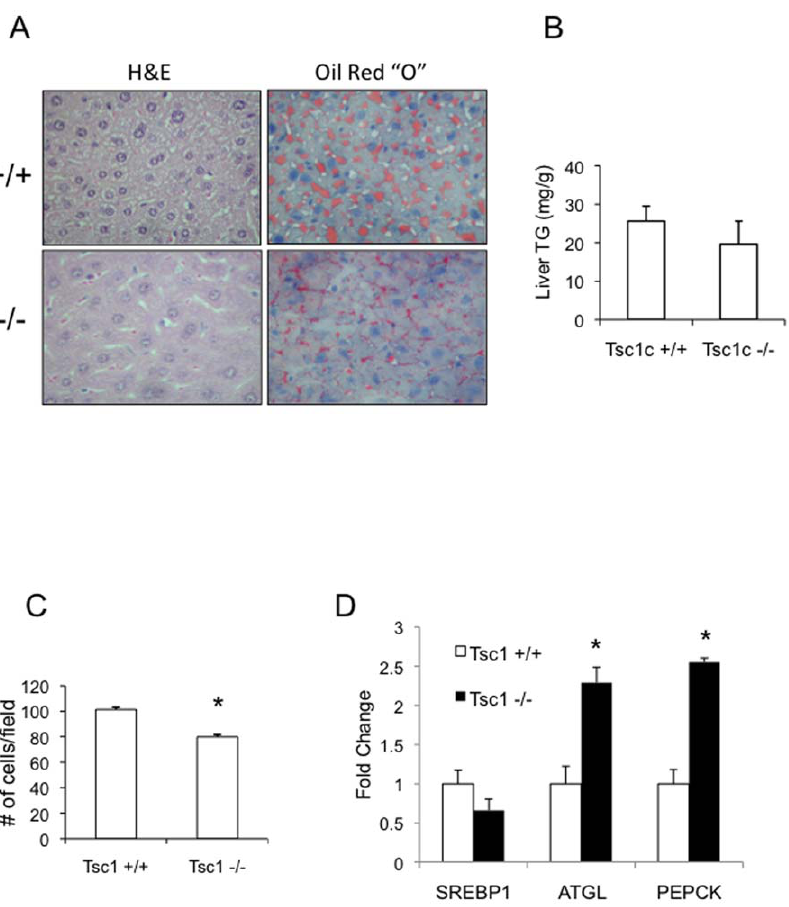
Figure 3. mTORC1 activity is not sufficient for steatosis. Normal chow-fed, 20-week old male Tsc1 + / + and Tsc1 2 / 2 male mice were fasted overnight and sacrificed. Liver tissues were processed for histologic and biochemical analyses. A) Liver histology (H&E) and Oil Red ‘‘O’’ staining showing hepatic morphology and lipid content. Magnification 400X. B) Quantification of liver triglyceride content using TG assay kit (Roche Diagnostics, see Methods). C) Hepatocyte cell size was deduced based on the average number of hepatocytes per high-power field from 10 randomly selected fields. *, p , 0.01 compared to Tsc1 + / + . D) Expression of genes involved in lipogenesis (SREBP1), adipogenesis (PPARg), lipolysis (ATGL) and gluconeogenesis (PEPCK) were determined by quantitative RT-PCR. *, p , 0.05 compared to Tsc1 + / + . For all graphs, values represent mean 6